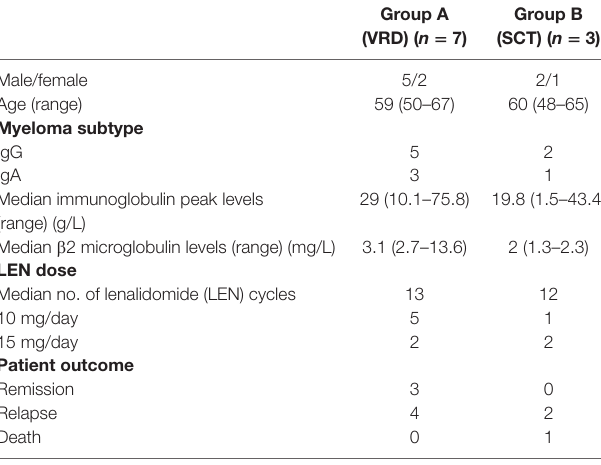
Table 1 | Clinical and biological characteristics of LEN-treated